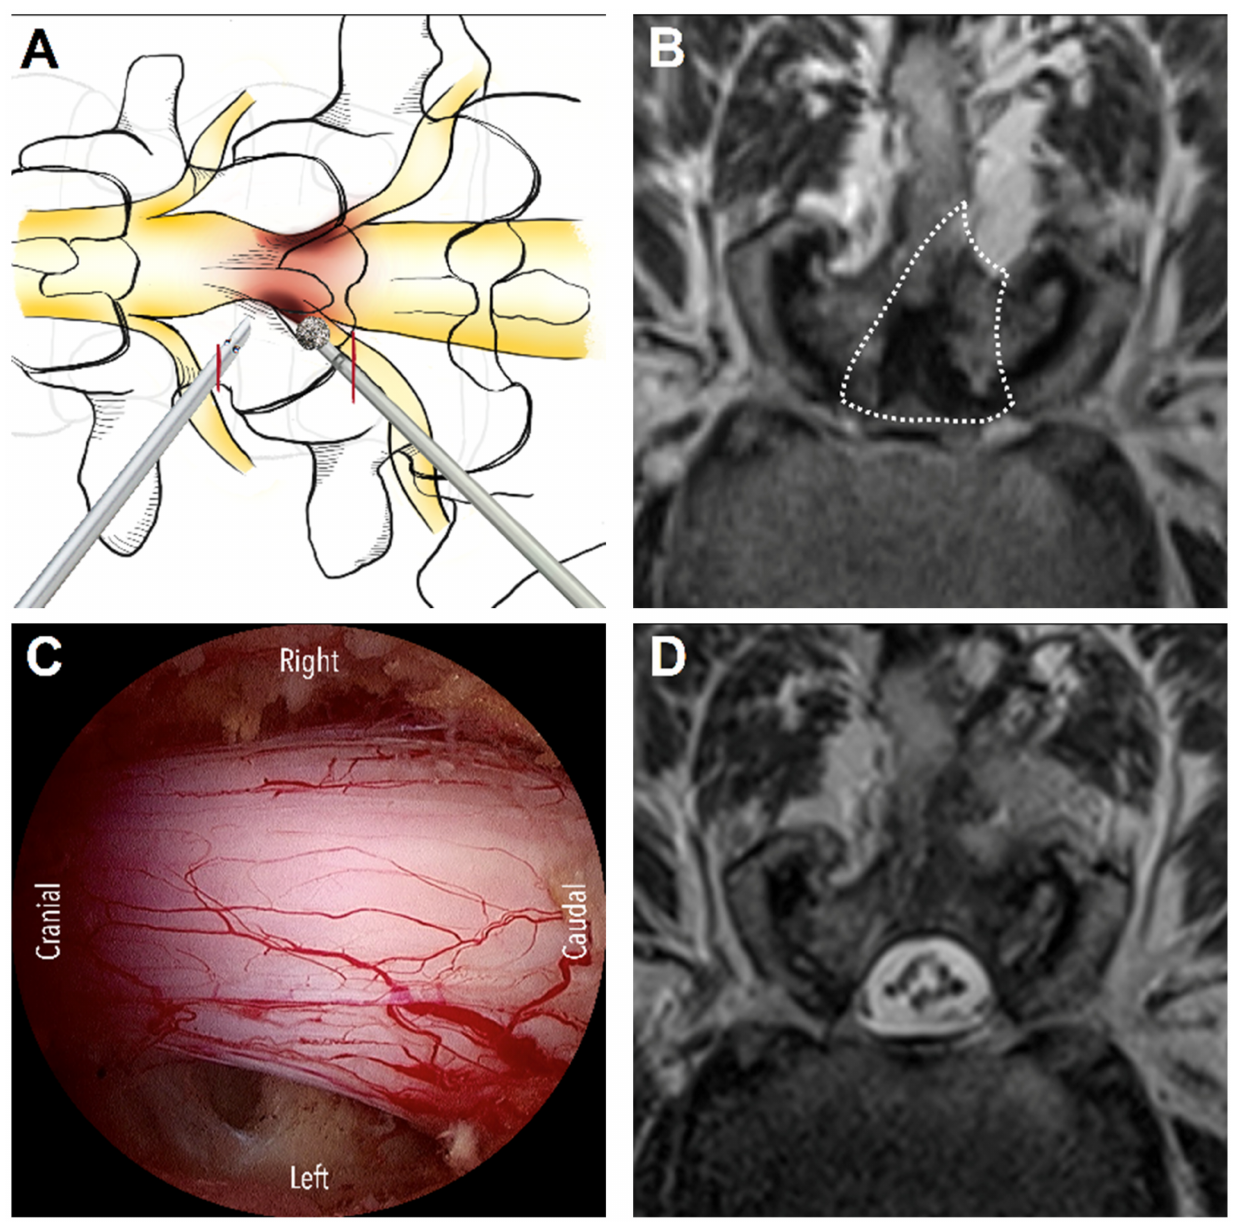
Figure 1. The interlaminar approach. ( A ) The schematic diagram illustrates the skin incisions (red lines) and initial target area of decompression from the left side: the junction of spinous process and lamina. ( B ) Pre-operative planning for bilateral decompression via unilateral laminotomy on MRI (dashed line area). ( C ) The endoscopic view demonstrates the complete decompression of central and bilateral lateral recess stenosis. ( D ) Postoperative MRI shows good decompression with good preservation of the facet joints and minimal soft tissue